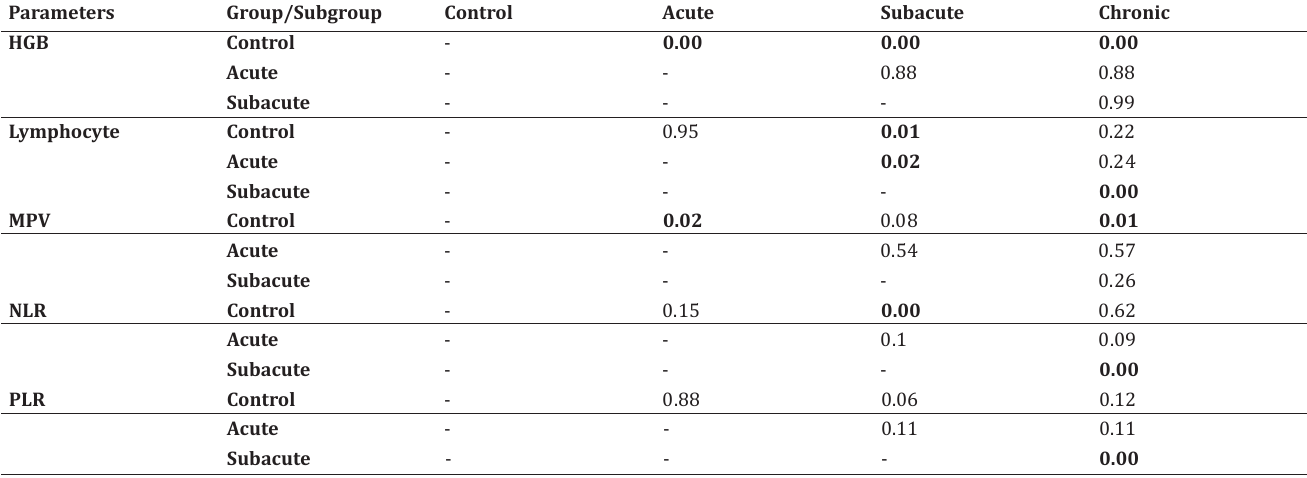
P-values of post-hoc and pairwise comparison tests for the significant hematological parameters